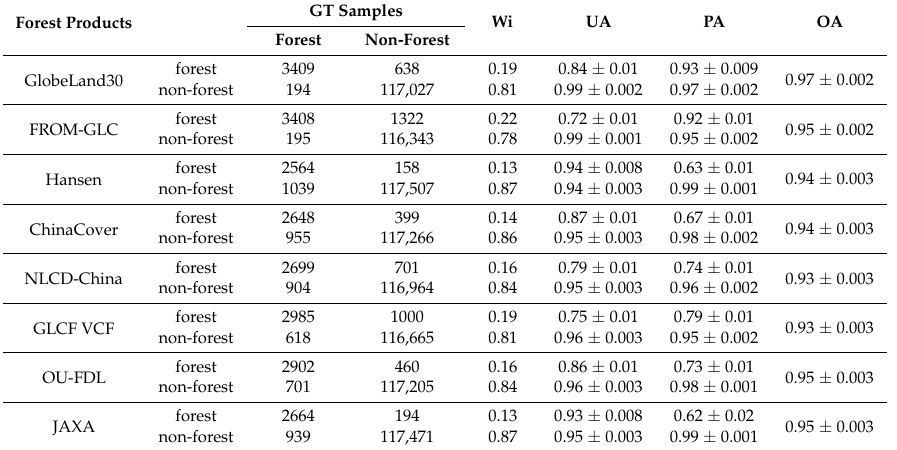
Table 2. Area-weighted confusion matrix of accuracy assessments of the eight forest products with a 95% confidence